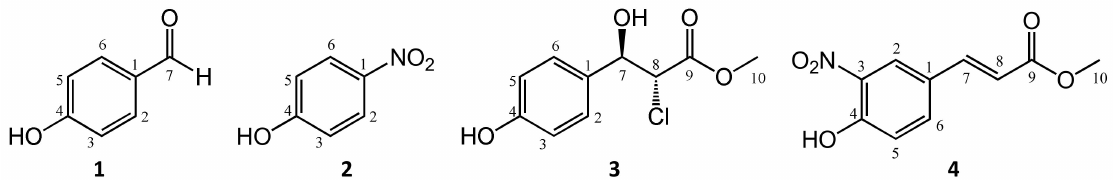
Figure 2. Structures of the metabolites 1 – 4 obtained from the reaction between pcm and peroxynitrite. For the racemic compound 3 only one enantiomer is shown for